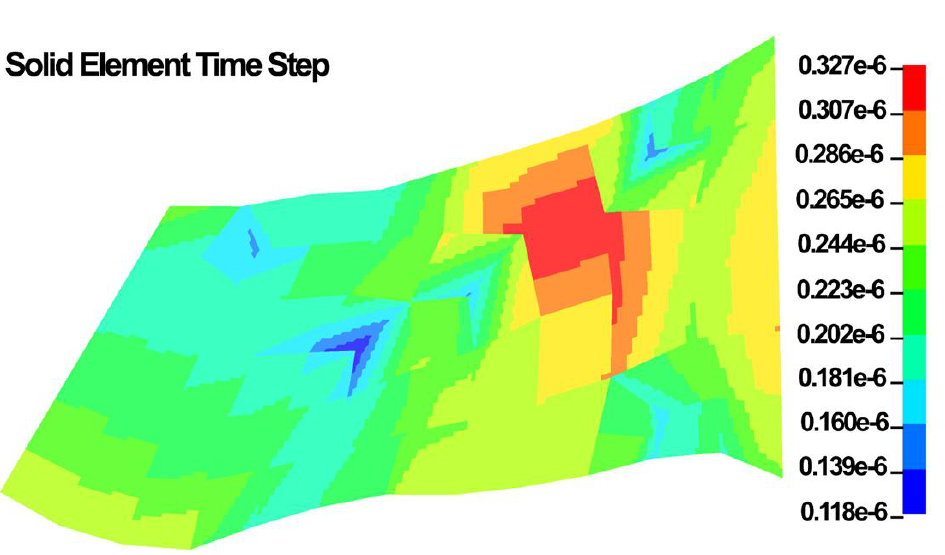
Figure 11. Solid element type step in the FE model.